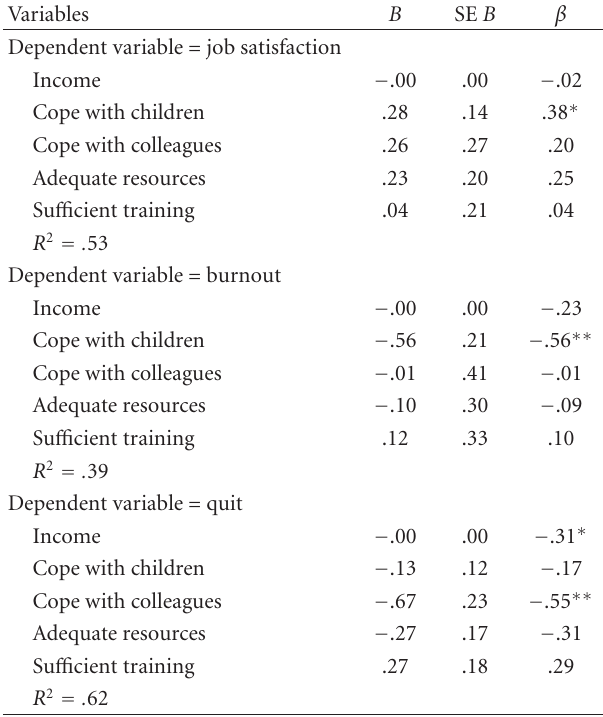
Table 2: Regression equations for job condition